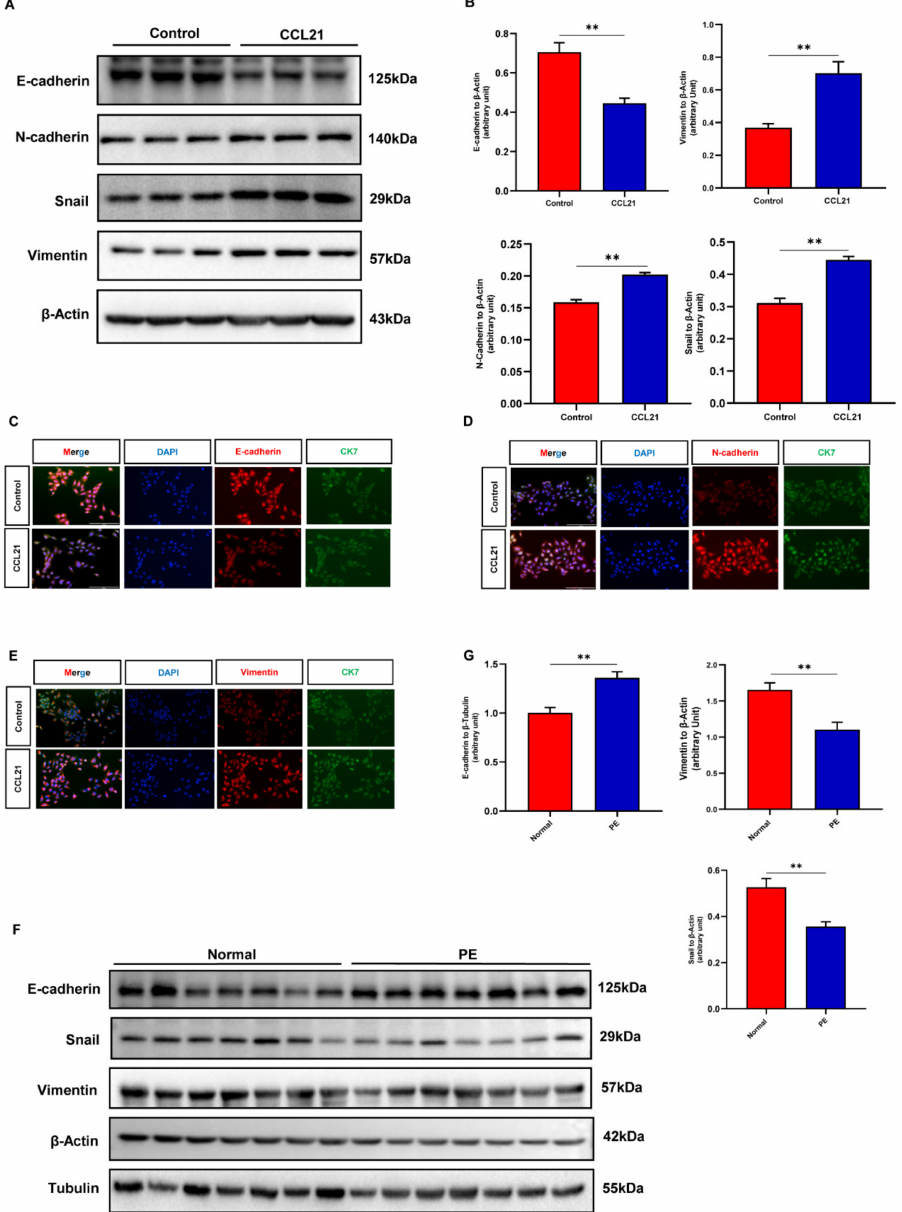
Figure 5. CCL21 contributed to the epithelial-to-mesenchymal transition process of HTR8/SVneo cells. The HTR8/SVneo cells were treated with 500 ng/mL of rhCCL21 for 48 h in a medium containing 0.5% FBS. ( A ) EMT biomarkers were detected by Western blotting between the treatment and the control groups (Supplementary File S1). ( B ) Statistical analysis of protein densitometry quantification in Figure 6A. ( C – E ) Cell immunofluorescence was used to measure the expression of EMT markers. Here, CK7 is indicated by green signals; E-cadherin, N-cadherin, and vimentin are indicated by red signals. ( F ) Western blotting was performed to analyze the expression of EMT markers in placental tissues from the PE patients and normal pregnancies (Supplementary File S1). ( G ) Statistical analysis of protein densitometry quantification in Figure 6F; ** p <